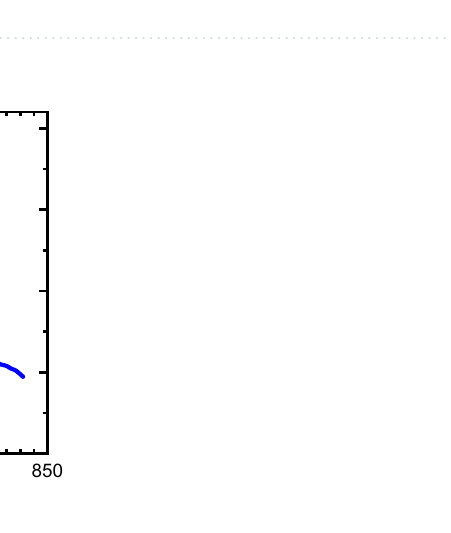
Figure 1. Excitation-emission contour plot for cured Type I/II cement in water. The color scale shows emission intensity in arbitrary units.